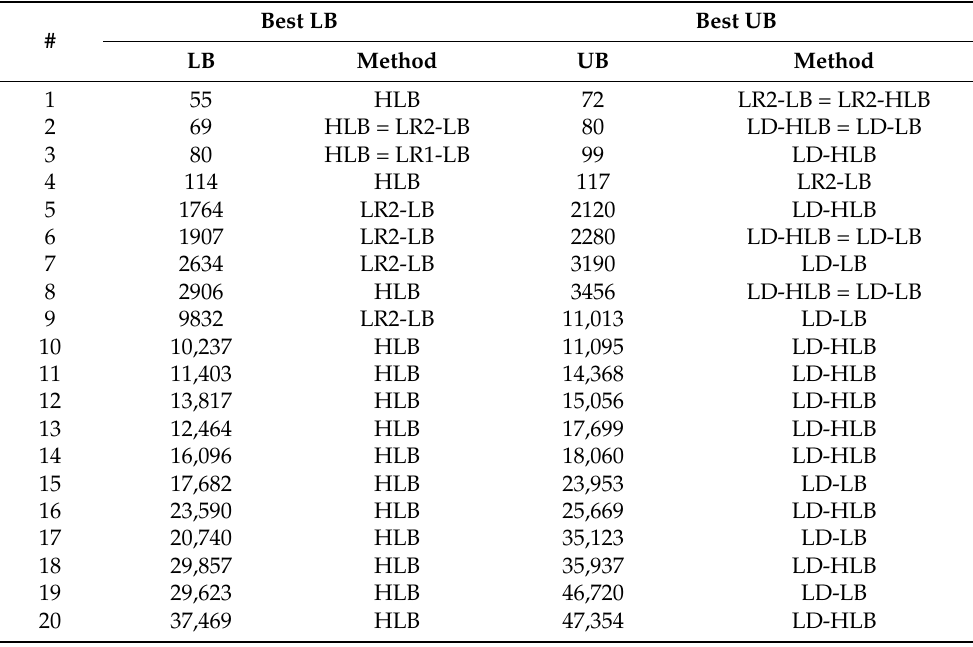
Table 12. Best lower bound and upper bound values and